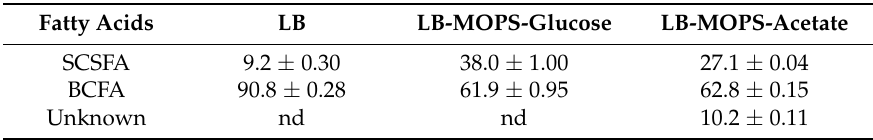
Table 7. Fatty acid composition (%) 1 in S. aureus Pig1 grown at stationary phase 2 in glucose or acetate containing LB broths.